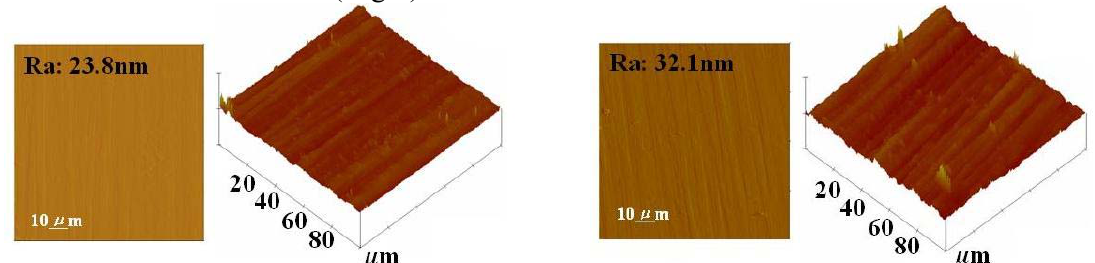
Figure 4. The AFM images before and after the formation of TES self-assembly monolayer on aluminum surface. (a) aluminum substrate untreated by TES (Left). (b) TES treated aluminum substrate